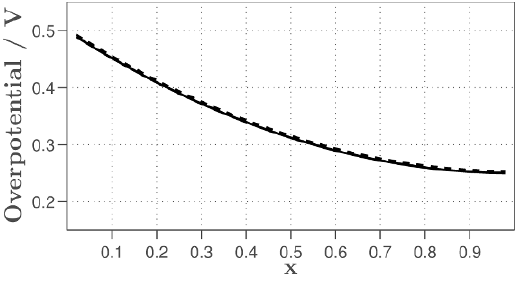
Figure 2. Analytic solution (28) of (26) (continuous line) and the numerical approximation (dashed line) using the method in (2) with T = 1 , N = 25 and τ = 0 . 01 for the test problem in subsection 4.3 . The remaining parameters are given in